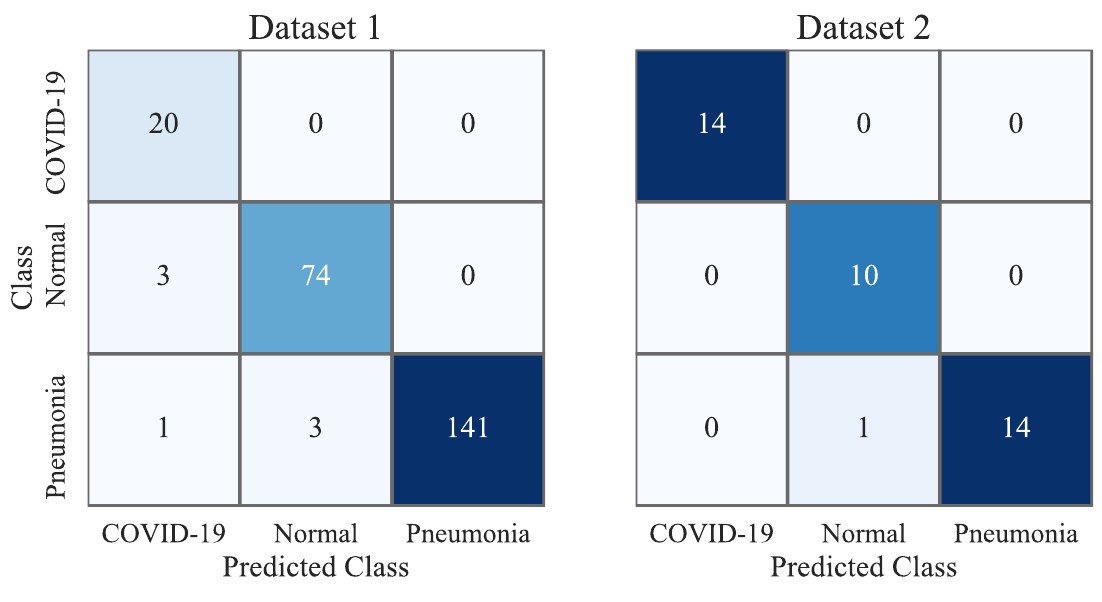
Figure 8. Confusion Matrix for Datasets 1, 2